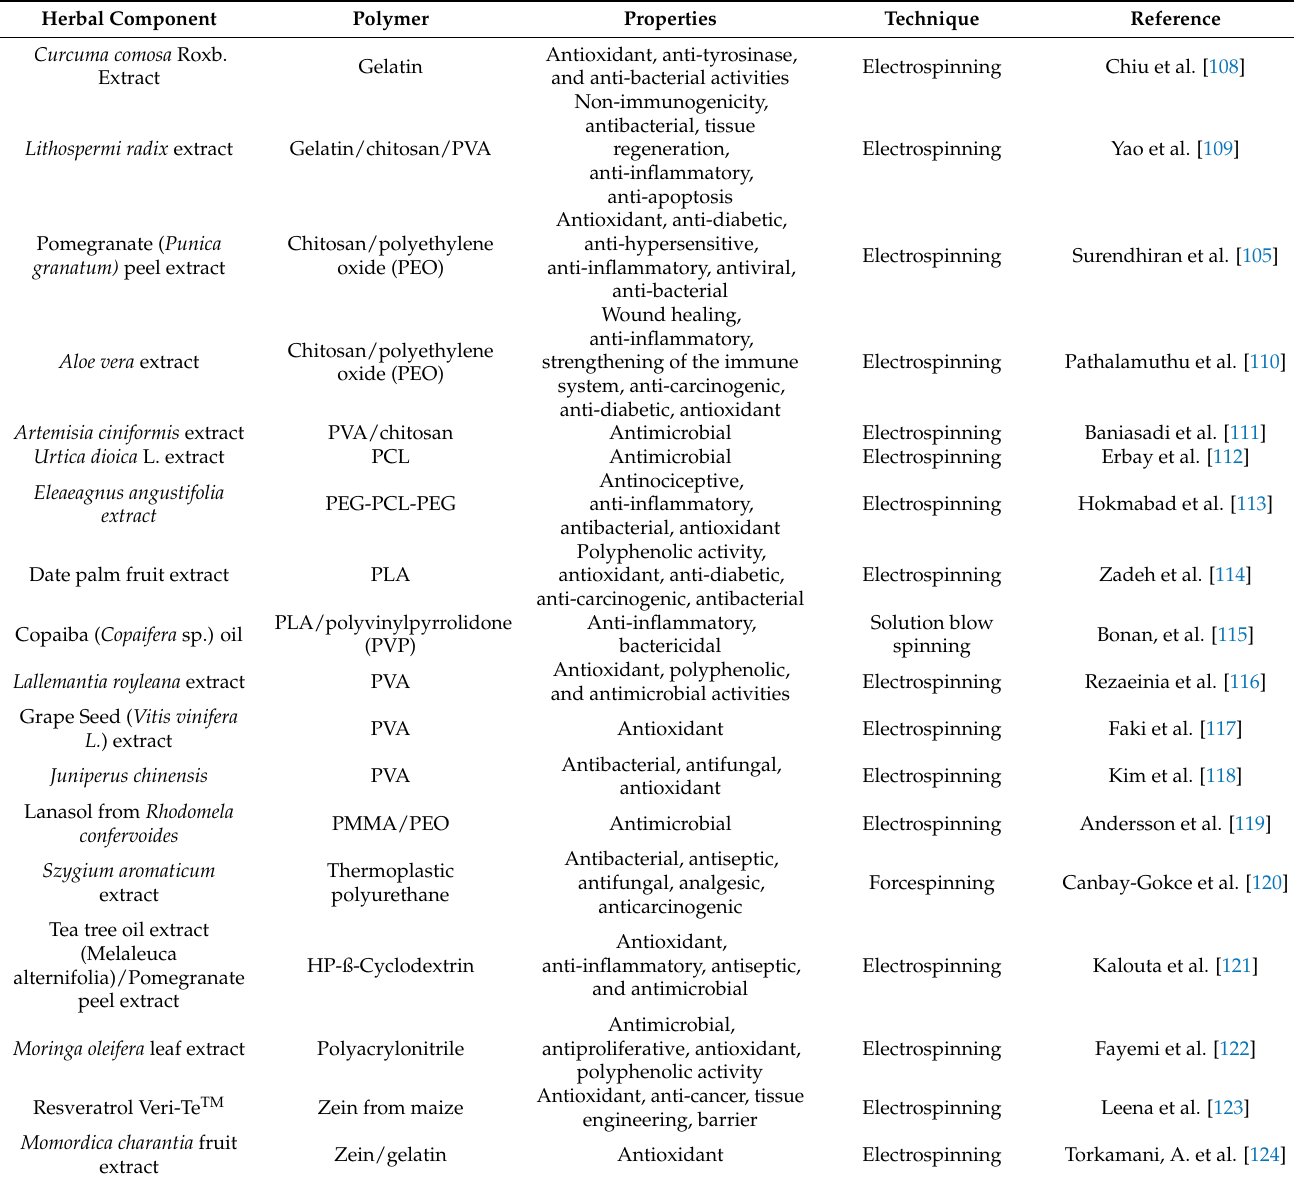
Table 3. Natural herbal extracts incorporated into polymer